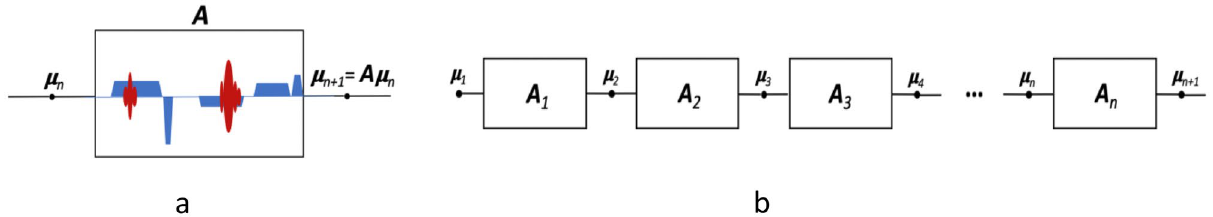
Figure 1. (a) Illustration of the “propagator”: a single block of events. μ is the input–output magnetization, in red the RF excitations and in blue the gradients. (b) A typical train of blocks in a MR pulse sequence. We will use identical blocks or operators A = A 1 = A 2 = … = A n